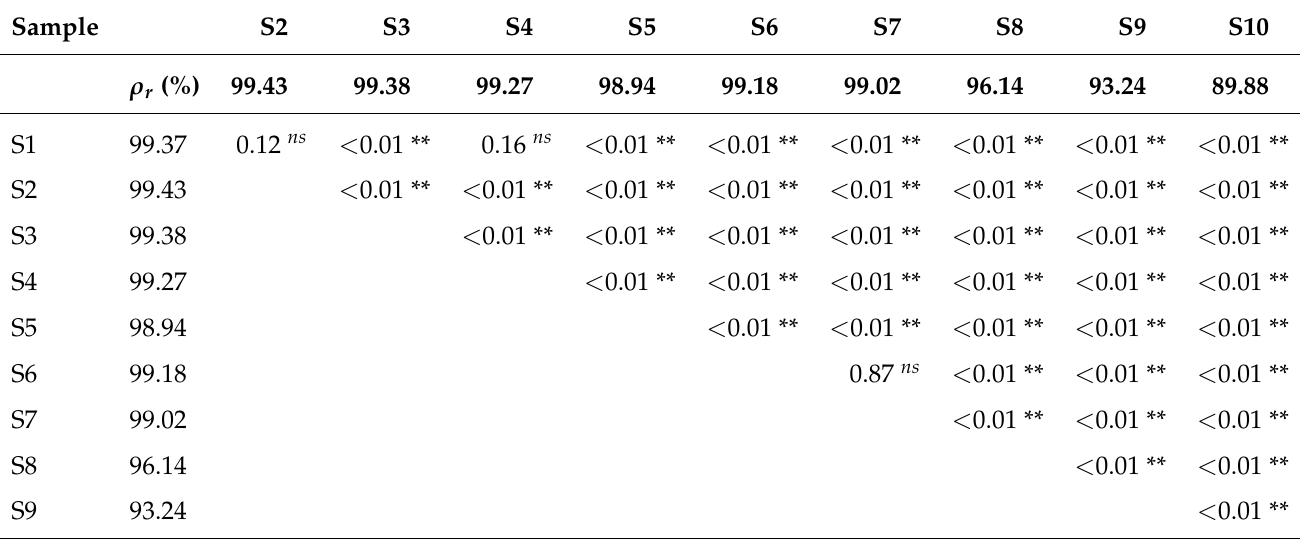
Table 3. Results of the pairwise multiple comparisons using the Games–Howell post hoc test based on Welch’s analysis of variance ( F ( 9, 844 ) = 59847, p < 0.01). The samples with sample size n = 209 were obtained from a 2 × 5-mm 2 (X × Y) region in the center of each of the 10 parts (316L). ** p < 0.01, * p < 0.05, ns not significant.